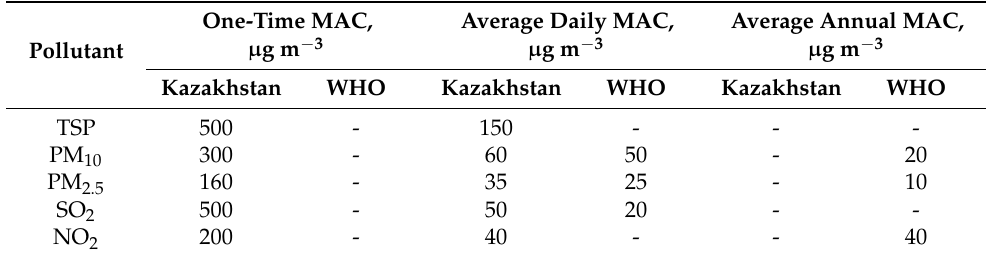
Table 1. Limit values of the WHO and Kazakhstan for the level of pollutants in the air. One-Time MAC, Average Daily MAC, Average Annual MAC, µ g m − 3 µ g m − 3 Pollutant Kazakhstan WHO Kazakhstan WHO Kazakhstan TSP - PM 10 SO 2 NO 2 200 -